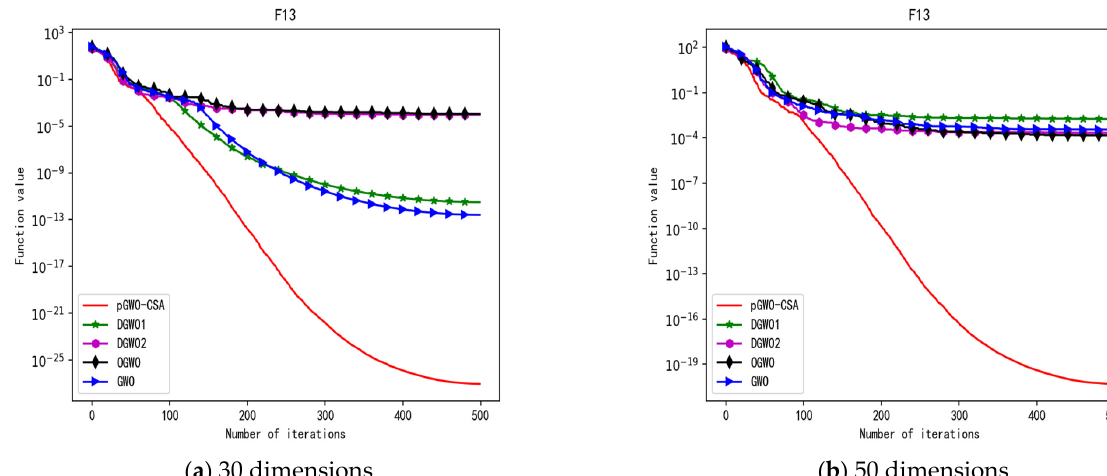
Figure 32. Convergence curve of test function F12.